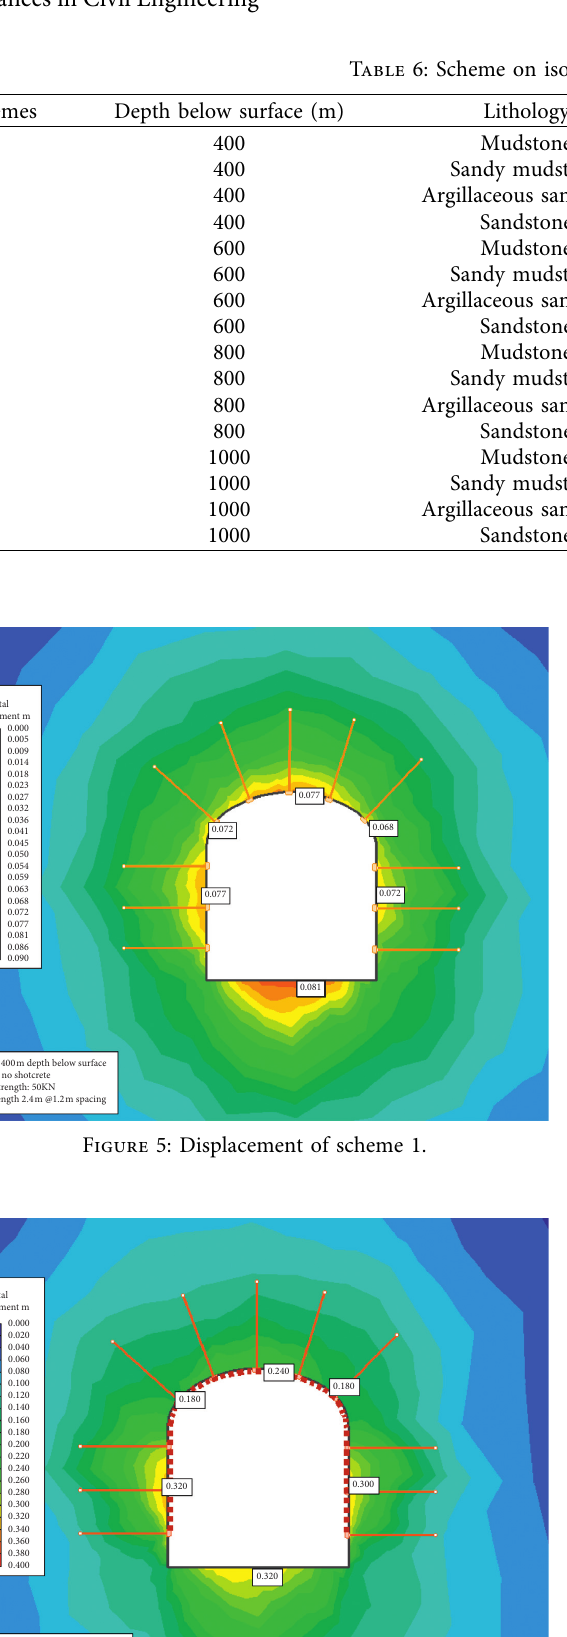
Figure 6: Displacement of scheme 5.